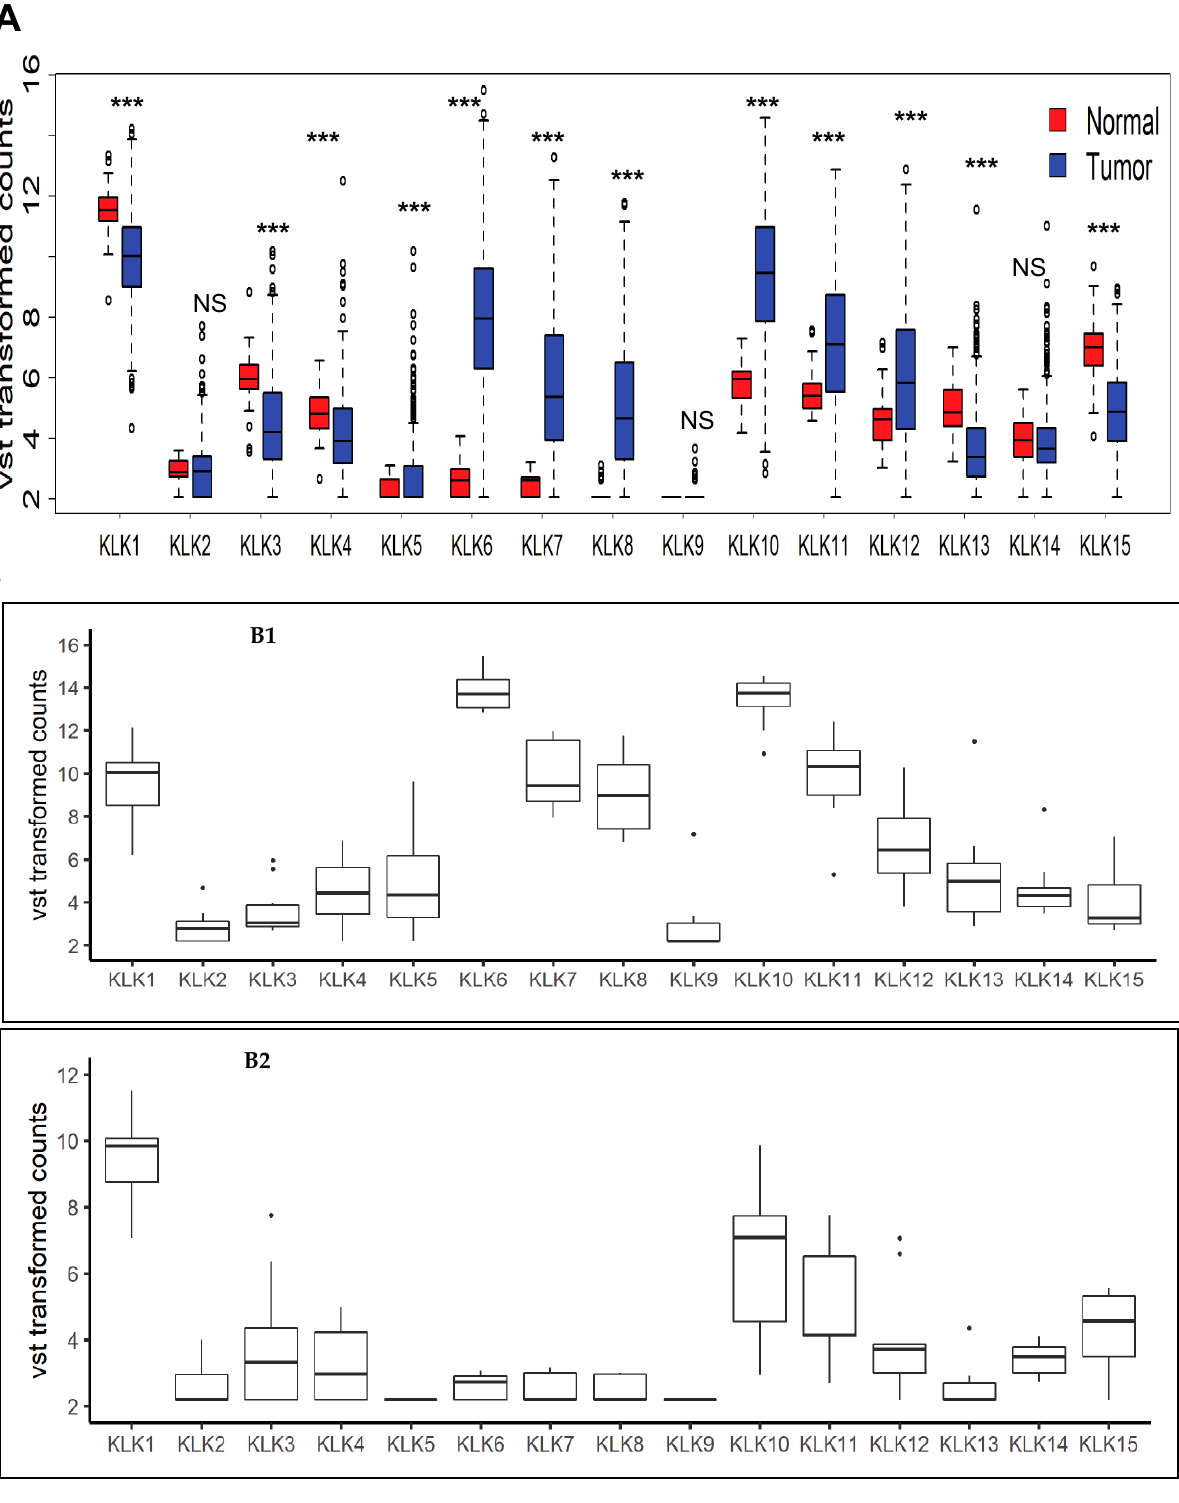
Figure 1. Expression of all members of Kallikrein related peptidase family in colon adenocarcinomas TCGA patient samples. ( A ) Box plot shows expression of KLK gene family normalized by Variance Stabilizing Transformation (VST) method in colon tumors and their relative expression in normal tissues. *** = p values < 0.0001, NS = Not Significant. ( B ) Box plots of KLK family from the CRC patient samples that have been identified as KLK6-high group and KLK6-low group. B1: Box plot of expression of all Kallikrein related peptidases in samples with high KLK6 expression (KLK6-high group) and B2: Box plot of expression of all Kallikrein related peptidases in samples with low KLK6 expression (KLK6-low